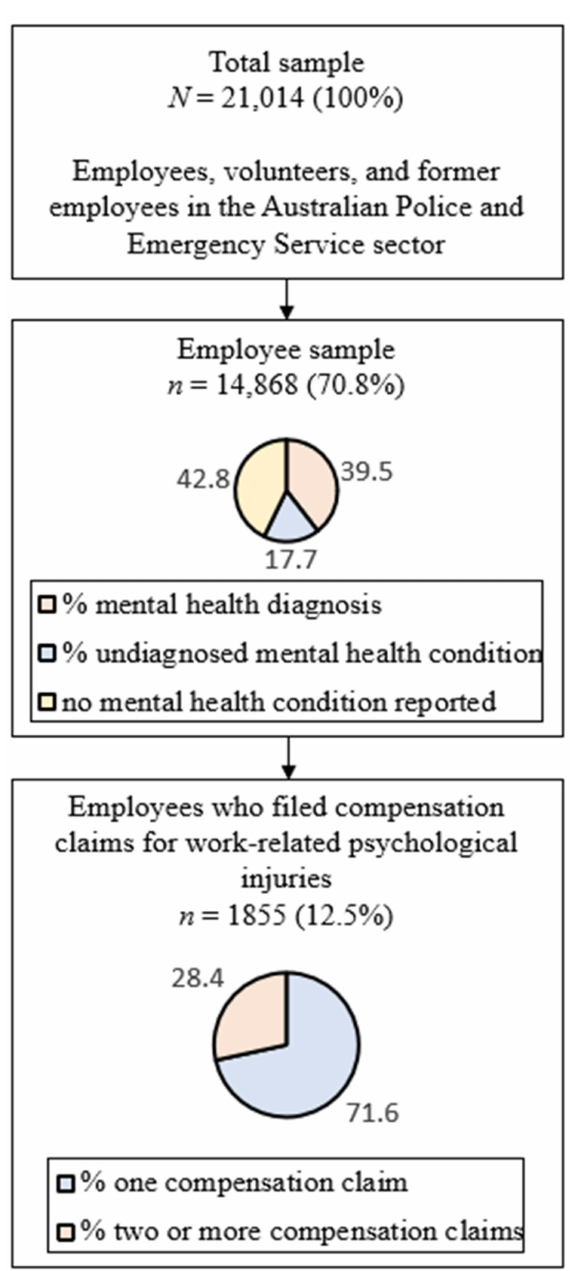
Figure 1. Flowchart presenting the participant composition of the Answering the Call